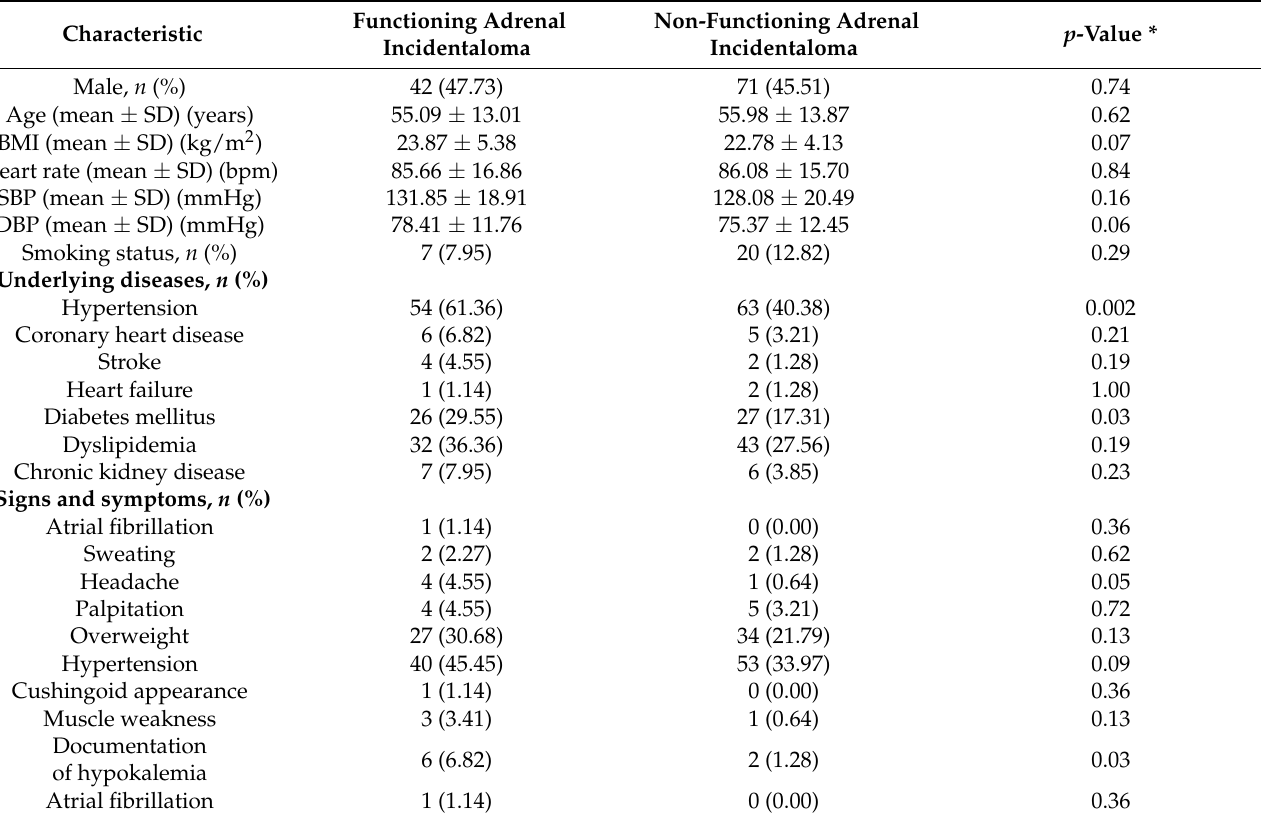
Table 1. Baseline demographic characteristics of patients with functioning adrenal incidentaloma ( n = 88) and non-functioning adrenal incidentaloma ( n =